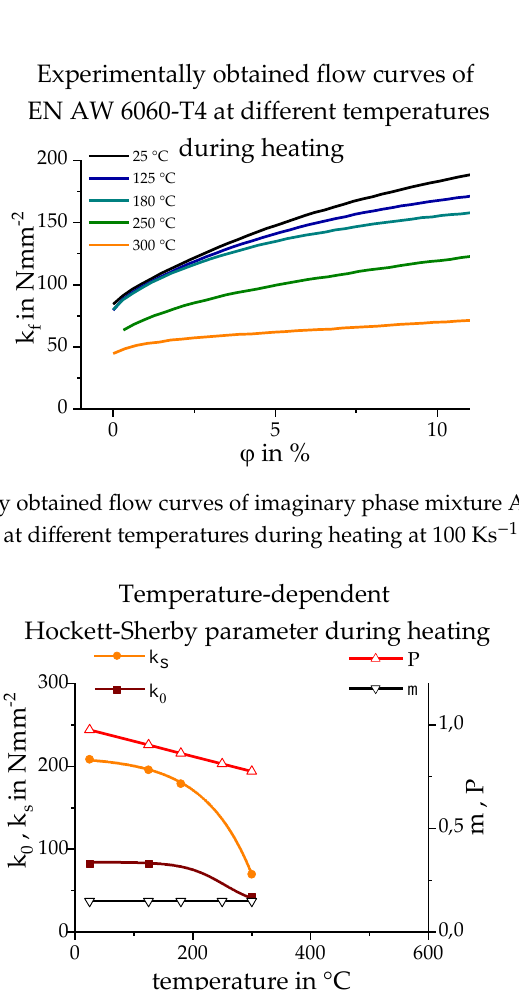
Figure 12. Temperature-dependent Hockett–Sherby parameters of imaginary phase mixture A + Z respectively Z + B during heating.